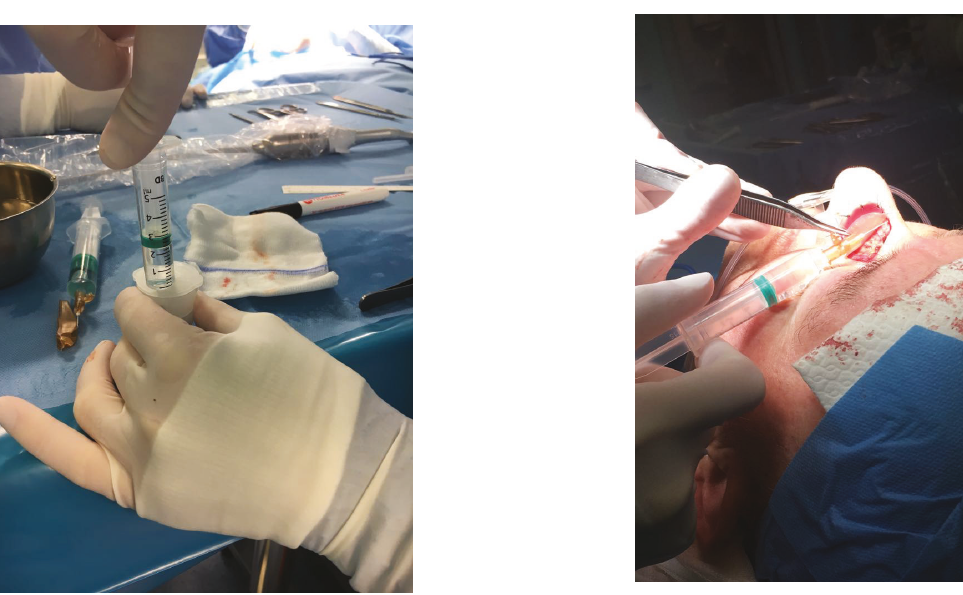
Figure 6: Aspiration of the micrografts containing saline solution with a sterile syringe.